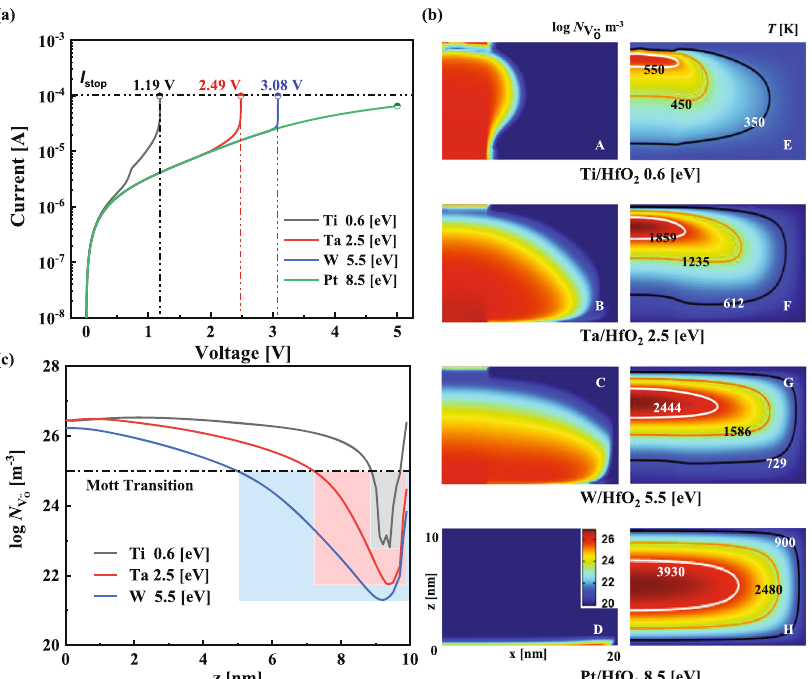
Fig. 2 Effect of electrode properties on the CF growth. a Current evolution characteristics with different electrode materials under an applied voltage sweep with rate d V /d t = 1 V s − 1 and stop at I stop = 100 µA or V app = 5 V. b 2D maps of distributions of N V :: at fi nal state. c 1D pro fi les of N V :: along the center of CF ( x = 0, z = 0 – 10 nm) at the fi nal state (the blue, red, and gray shades indicate the o position and width of the oxygen vacancy depletion